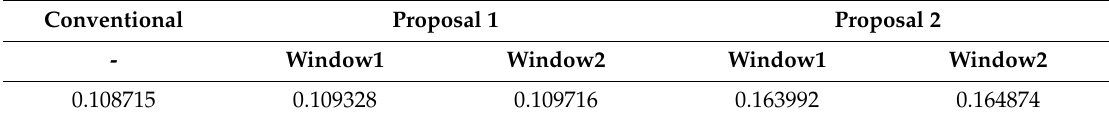
Table 10. Computational time of